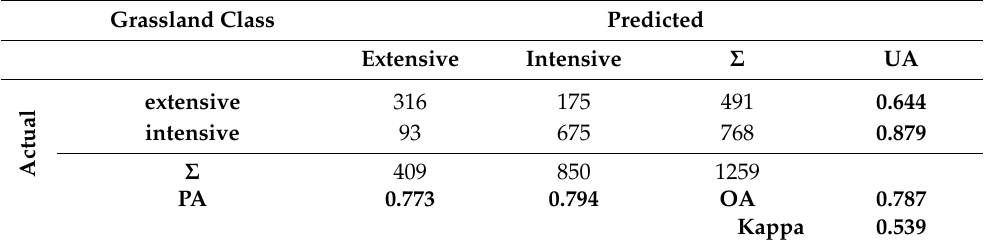
Table 3. Confusion matrices of the environmental variables with RF classifier.